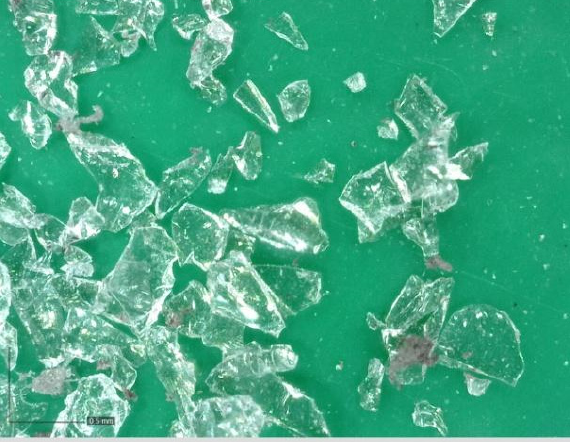
Figure 1. Glass recyclate fraction 0.0/0.5 mm; 103× magnified.